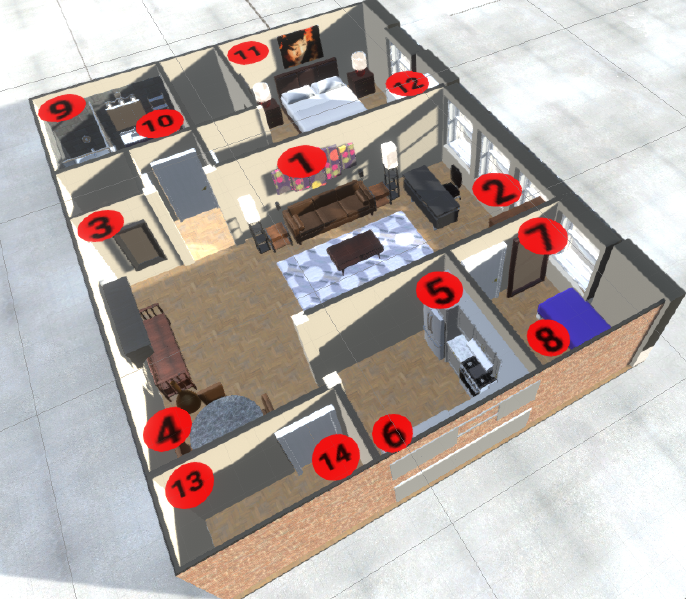
Figure 5. Diagram of sensor distribution by rooms in an average house for